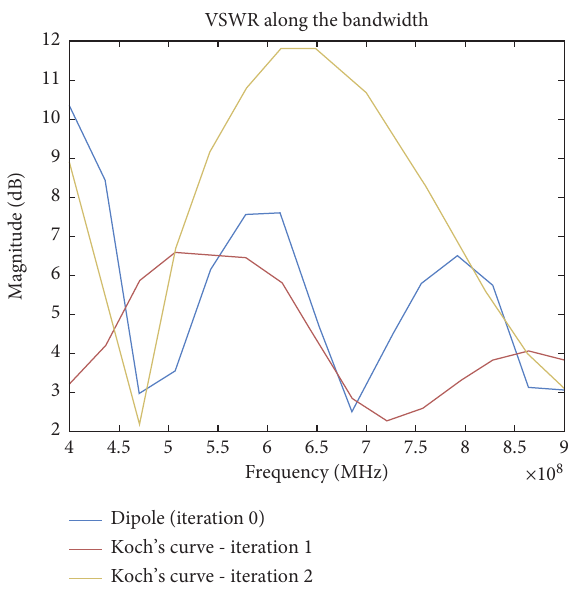
Figure 18: VSWR for dipole and Koch’s curve